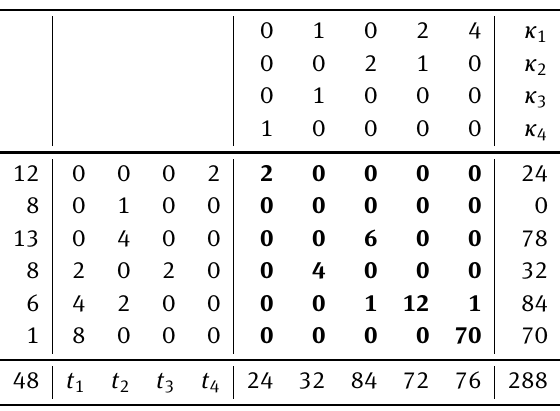
Table 7: Computation of the numbers a ( τ , κ )